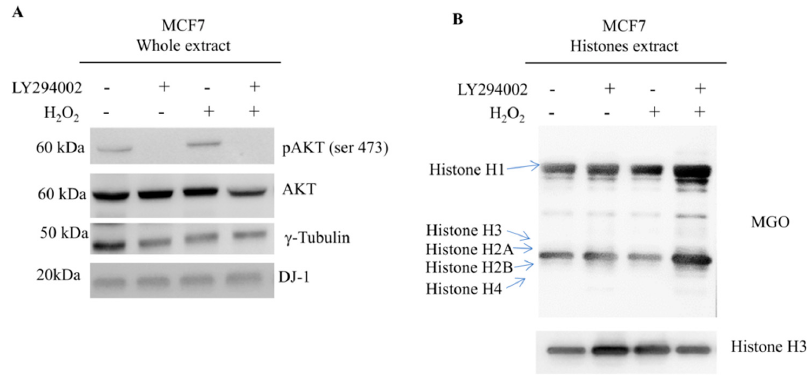
Figure 9. Western blot analysis relative to the expression of Akt activation and AGEs formations in MCF7 breast cancer cells ( A ) Western blot analysis on whole extract from MCF7. Levels of Phospho-Akt and DJ-1 are shown in loading control and treated cells. Signals of Phospho antibody were normalized against the total level of Akt. A goat polyclonal anti- γ -Tubulin antibody (C-20) was used to confirm equal loading of whole proteins. Proteins were resolved using Any kD Mini-PROTEAN TGX Precast Protein Gels and blotted using trans-blot turbo system (Bio-Rad). Signals intensities were assessed by densitometry using the Alliance 4.7 software; ( B ) Western blot analysis on histones extracts from MCF7. Levels of MGO are shown in loading control and treated cells for each histone isoforms resolved on the gel. The major level of MGO are detected on Histone H1. Histones were resolved using 15% Mini-PROTEAN TGX Precast Protein Gels and blotted using trans-blot turbo system (Bio-Rad). Signals intensities were assessed by densitometry using the Alliance 4.7